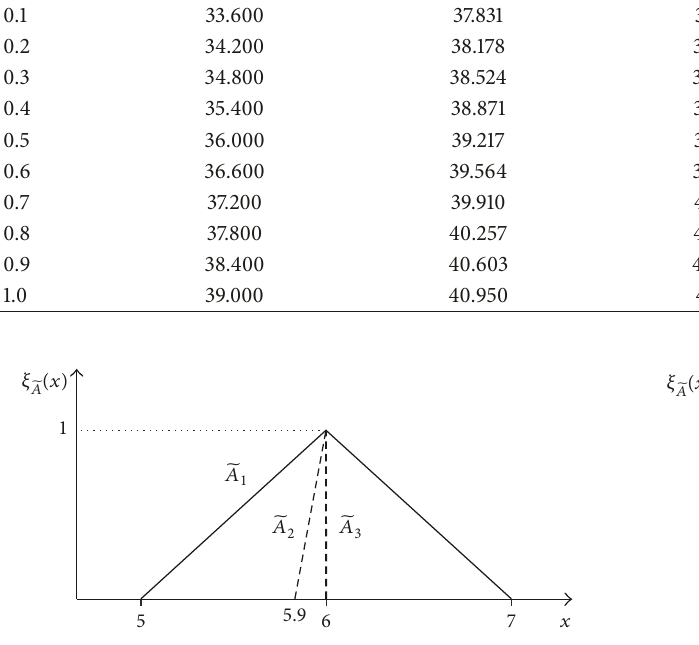
Figure 5: Fuzzy numbers